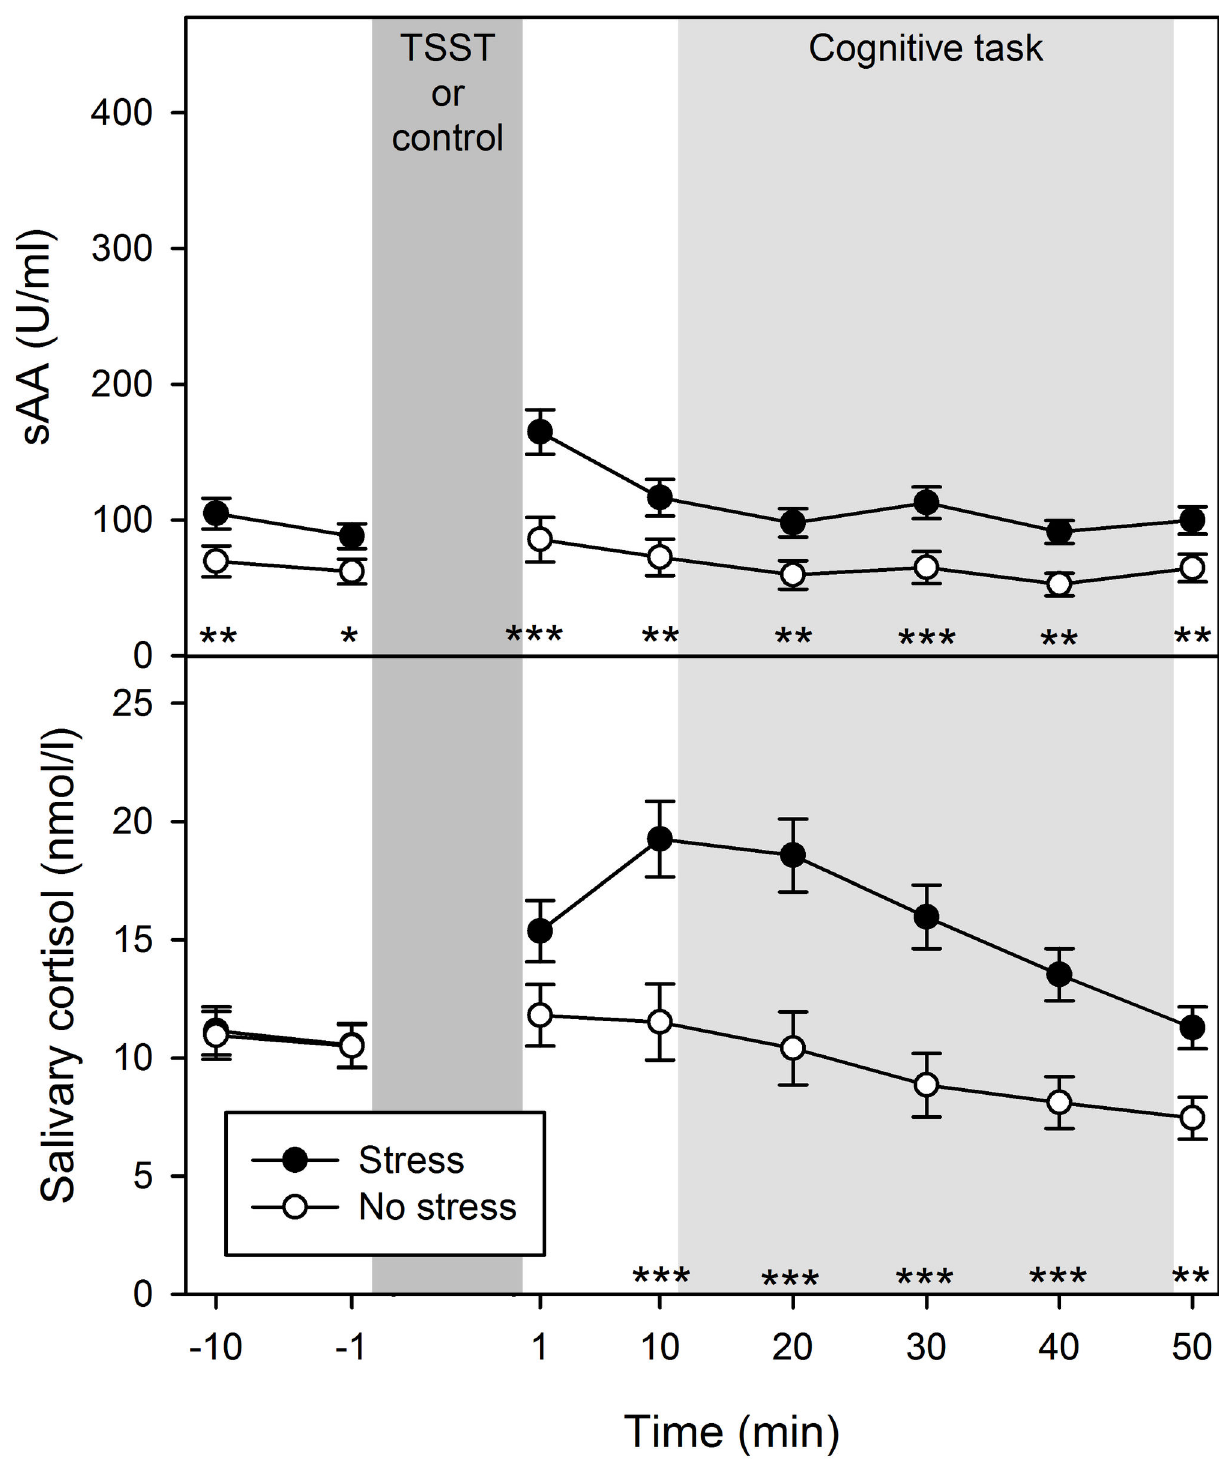
Figure 2. Neuroendocrine measures. Mean salivary α-amylase (sAA) and cortisol levels for the stress group and the no-stress group over the time-course of the experimental session (minutes before or after the Trier Social Stress Test [TSST] or the control condition, respectively). Error bars represent standard errors. * p < .05, ** p < .01, *** p < .001.